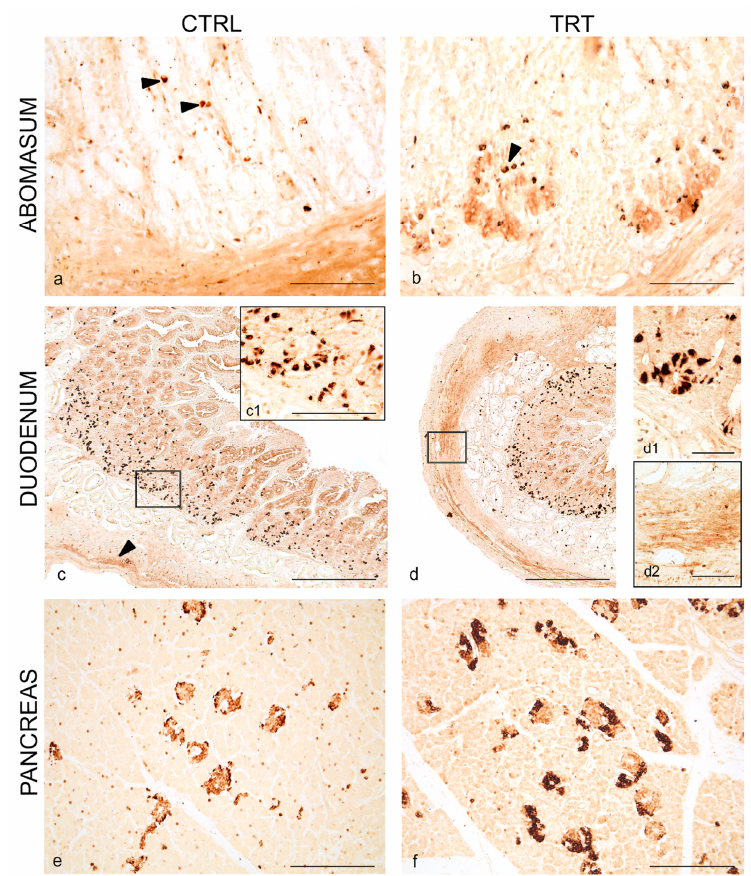
Figure 1. Neuropeptide Y (NPY) immunoreactivity in the abomasum, duodenum and pancreas of control and treated goat kids. Scattered positive cells (arrowheads) in the epithelium of gastric mucosa of control ( a ) and anthocyanins (ANTs) fed animals ( b ). Overview of NPY distribution in neuroendocrine cells ( c ) in the crypt of Lieberkühn and varicose positive fibers (arrowhead) in the muscular layer of duodenum of control ( a ) and ANTs fed animals ( d ). Higher magnification of neuroendocrine cells in the crypt of Lieberkühn ( c1 – d1 ) and fibers in the muscular layer ( d2 ). Overview of NPY distribution in the pancreatic islets of control ( e ) and ANTs fed animals ( f ). Scale bar: (a,b,e,f) = 50 μm; (c,d) = 100 μm; (c1,d1,d2) = 25 μm.